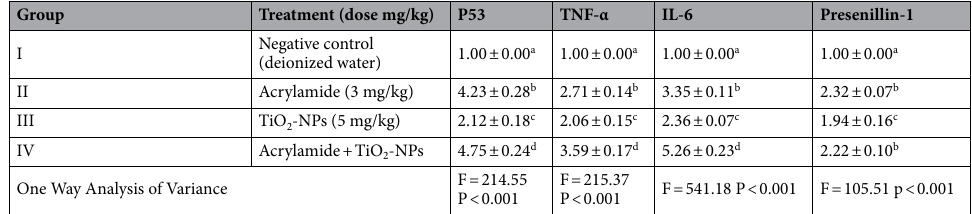
Table 3. Expression level of p53, TNF-α, IL-6 and Presenillin-1 in the brain tissue of the negative control group and groups administered acrylamide or/and TiO 2 NPs. Results are expressed as mean ± SD. Results were analyzed using one-way analysis of variance followed by Duncan’s test to test the similarity between the control and three treated groups. Means with different letters indicates statistical significant difference between the compared groups in the same